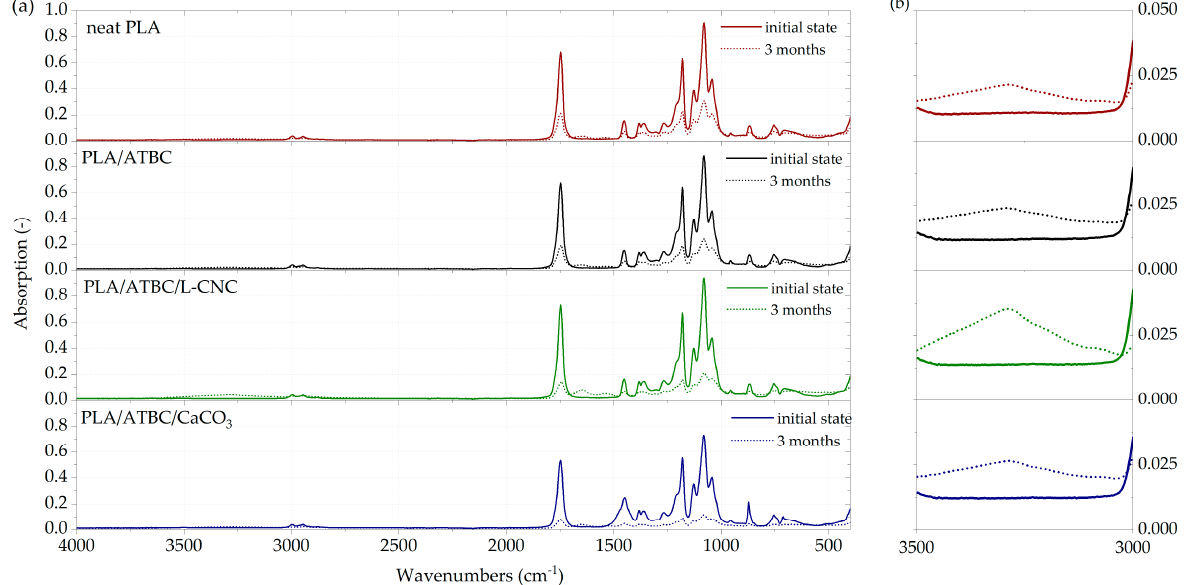
Figure 2. FTIR spectra of PLA biocomposites. ( a ) At initial state and after three months of biodegradation in freshwater biotope. ( b ) Occurrence of hydrolysis degradation.